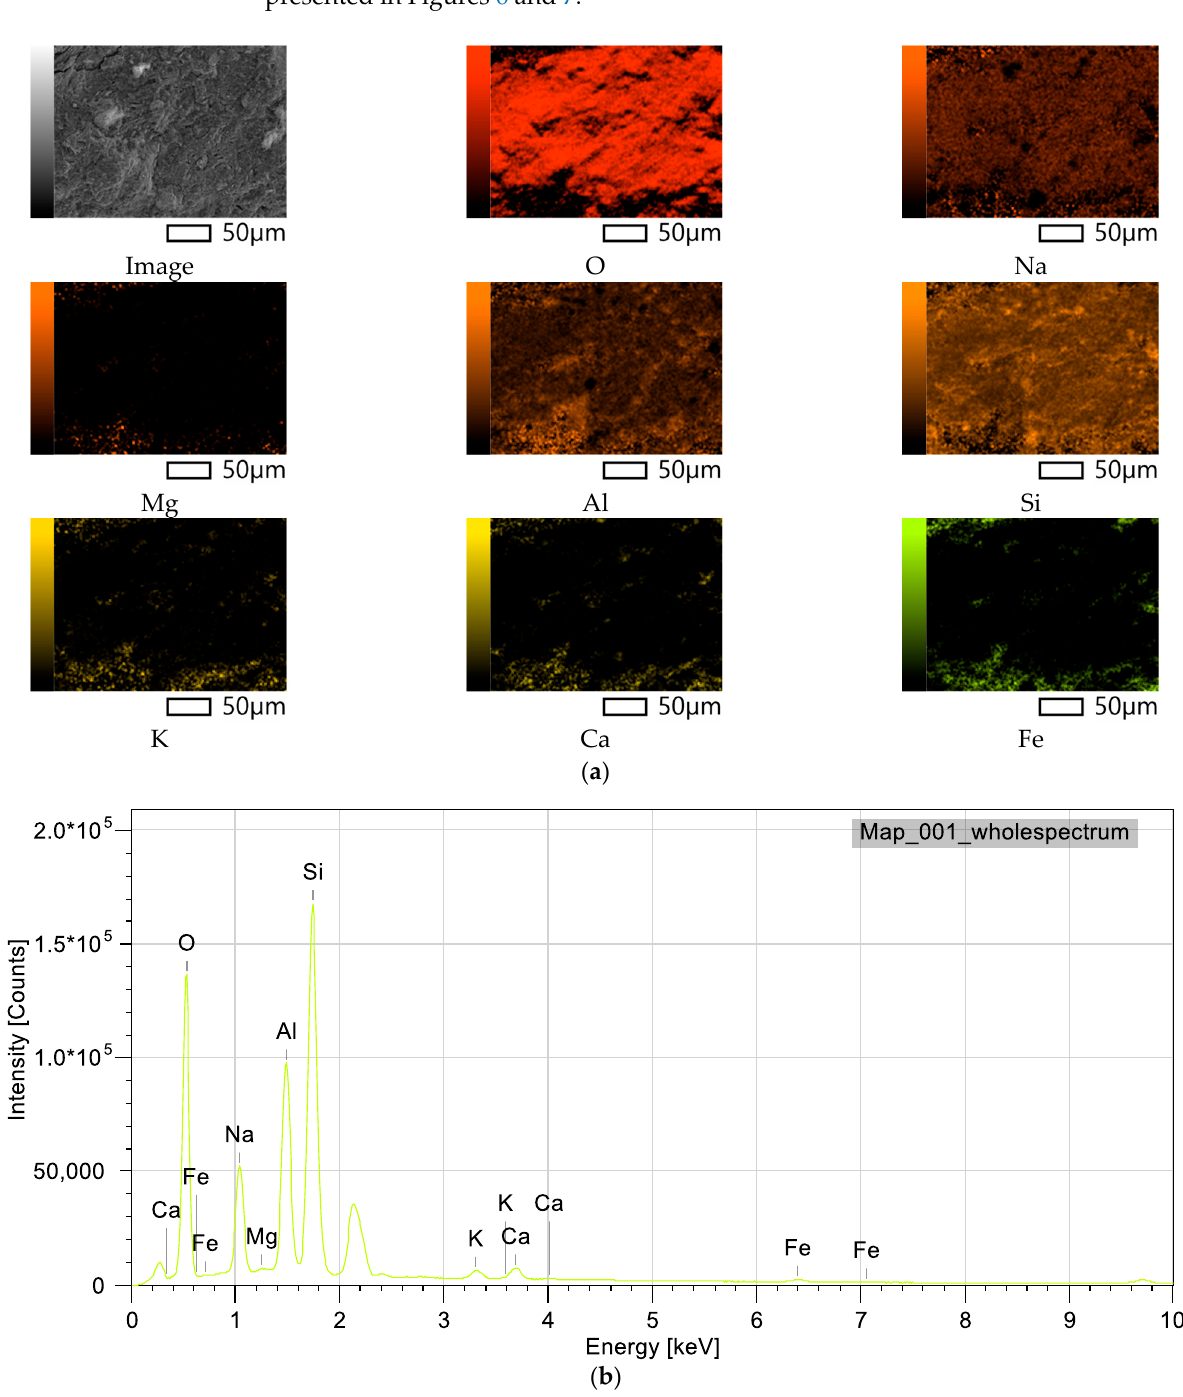
Figure 6. SEM images of sample G1 ( a ) elemental mapping; ( b ) whole spectrum.